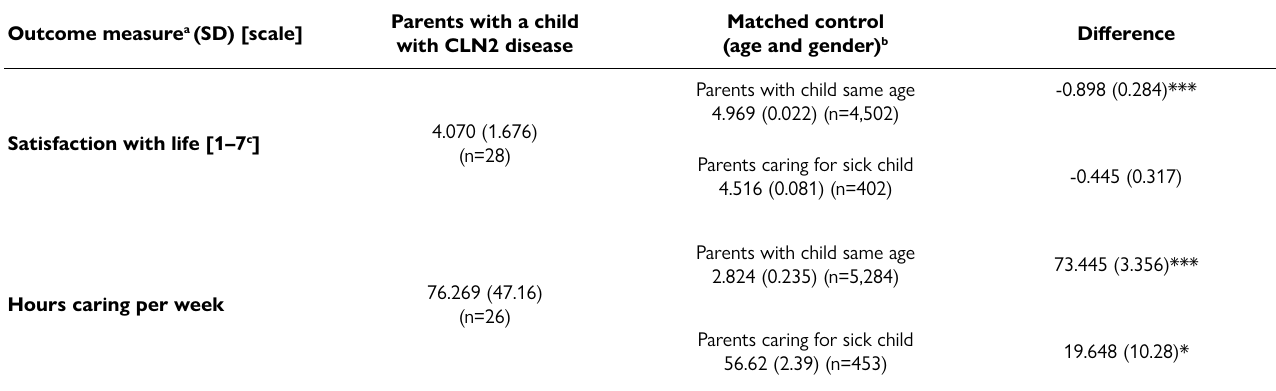
Table 7. Health and wellbeing outcomes for caregivers compared with norms (excludes adult siblings) Outcome measure a (SD) [scale]